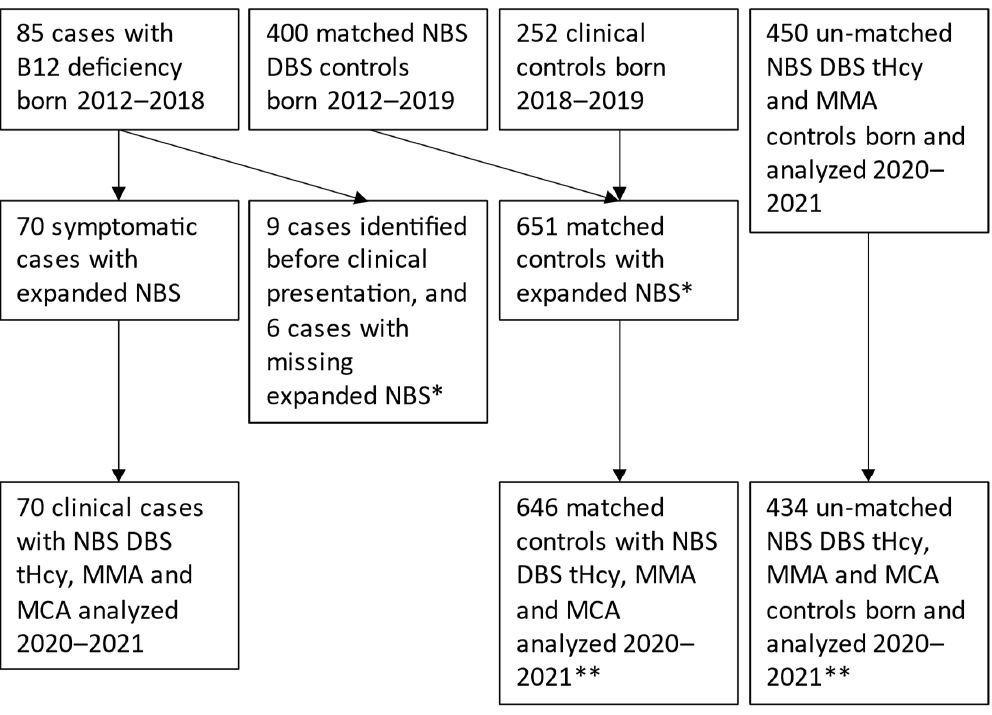
Figure 1. Inclusion of clinical cases and controls, * = missing infants born before 2012, missing expanded NBS, ** = missing infants with unsuccessful 2nd tier analyses, NBS = newborn screening, DBS = dried blood spot, tHcy = total homocysteine, MMA = methylmalonic acid, MCA = methyl citric acid.